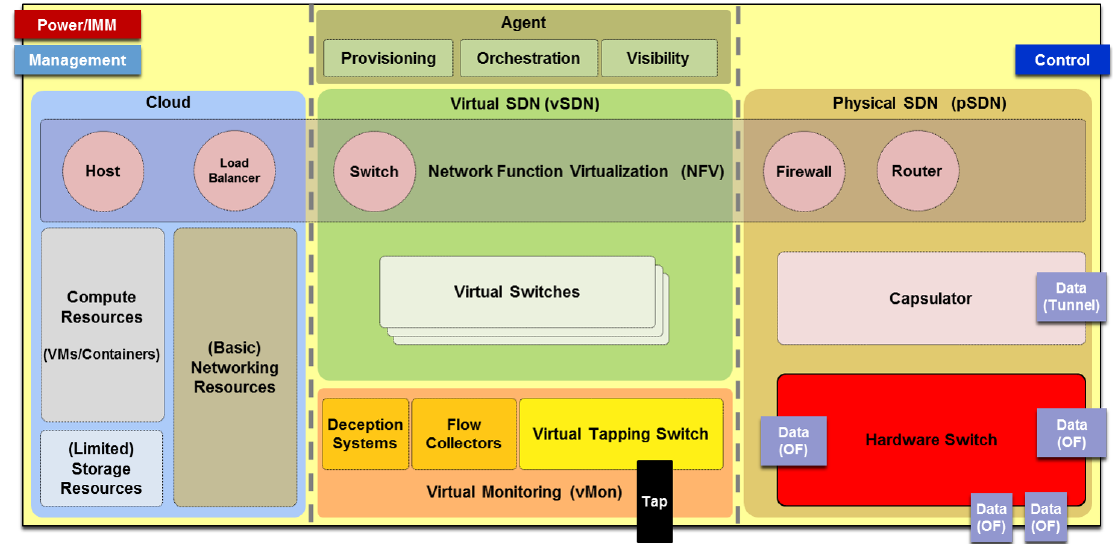
Figure 5. Hyper-converged SmartX Box: Abstraction to match SDN/NFV/Cloud